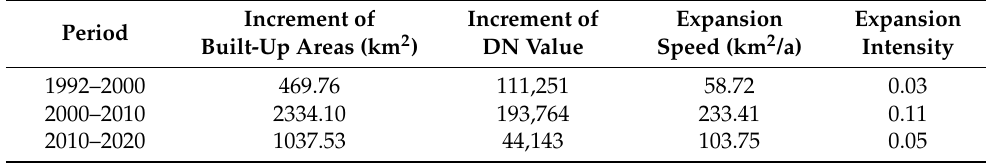
Table 1. Changes in City-scale Expansion of the Beijing–Tianjin–Hebei Urban Agglomeration from 1992 to